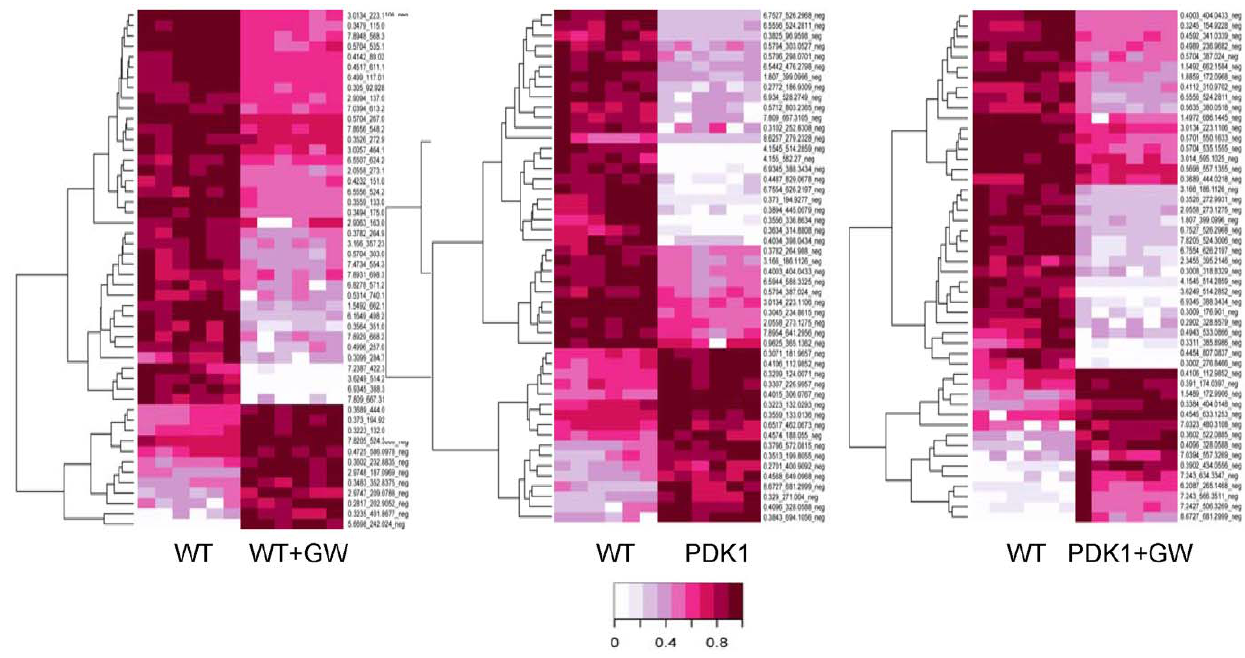
Figure 4. The metabolome of GW501516-treated wild-type and MMTV-PDK1 mice. Wild-type ( WT ) and MMTV-PDK1 ( PDK1 ) mice were maintained for 7 days on either standard or GW501516 ( GW )-supplemented diets. The metabolite levels in mammary gland extracts were analyzed by UPLC-ESI-TOFMS. The heatmaps depict the changes in negative ions for control and GW-treated WT and PDK1 mice in 6 replicate analyses.